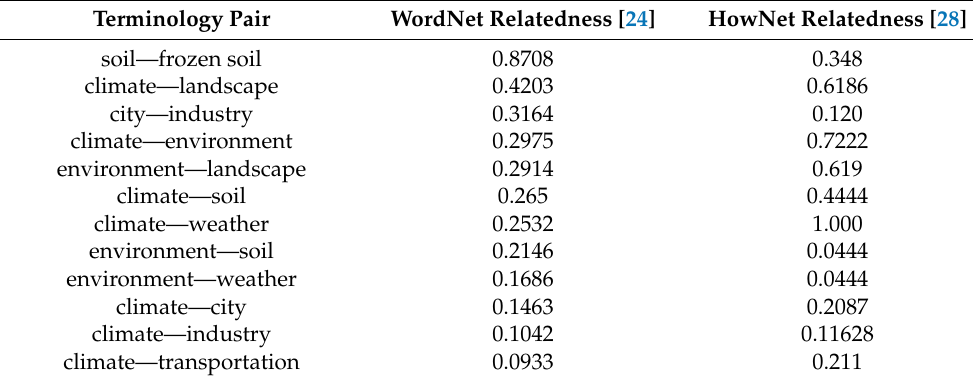
Table 8. The top terms’ relatedness computed by different lexical database-based